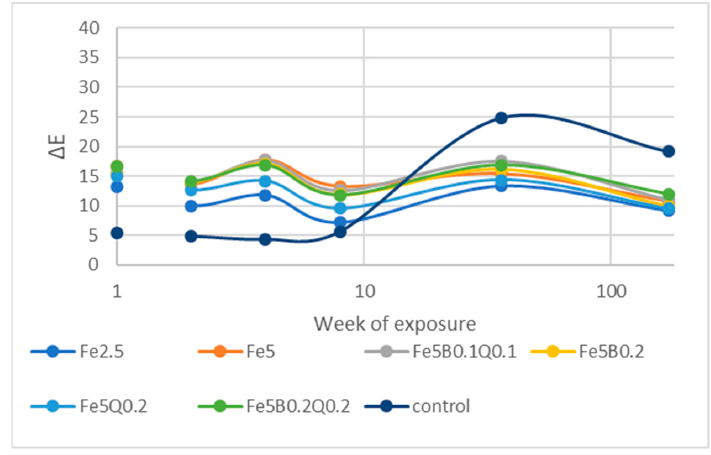
Figure 5. Mean colour change ( Δ E) of control and treated Siberian larch samples following outdoor exposure. The compositions of treatments are presented in Table 1. The x -axis is a logarithmic scale.